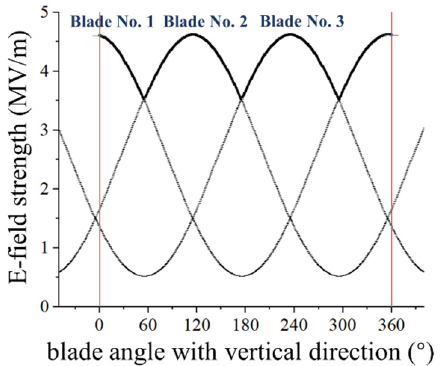
Figure 7. Periodic variation of E ‐ field on blade tip of rotational wind turbine.